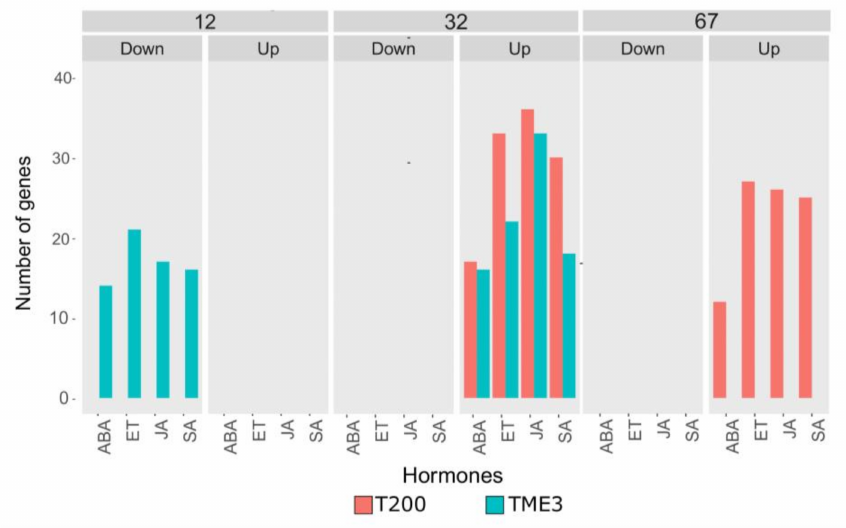
Figure 8. Number of upregulated or downregulated genes associated with enriched phytohormone GO terms (biological processes) in T200 and TME3 at 12, 32 and 67 days post inoculation with South African cassava mosaic virus